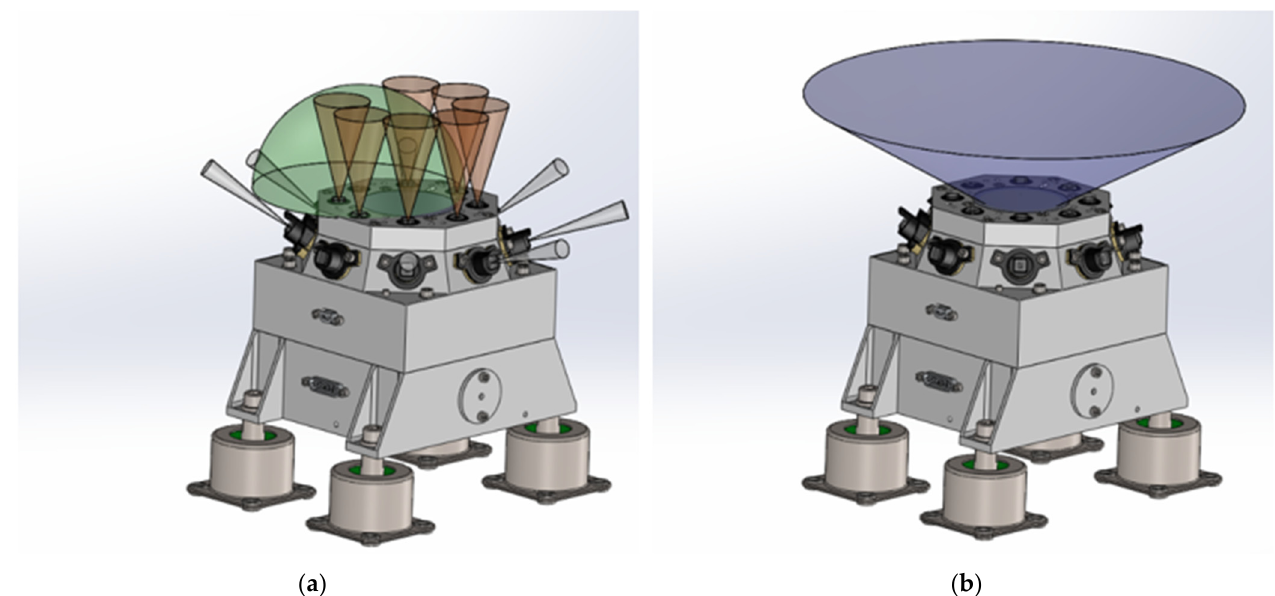
Figure 1. RDS assembly with field of view detail for each detecting technology: ( a ) RDS-discrete photodetectors; ( b ) RDS-SkyCam.